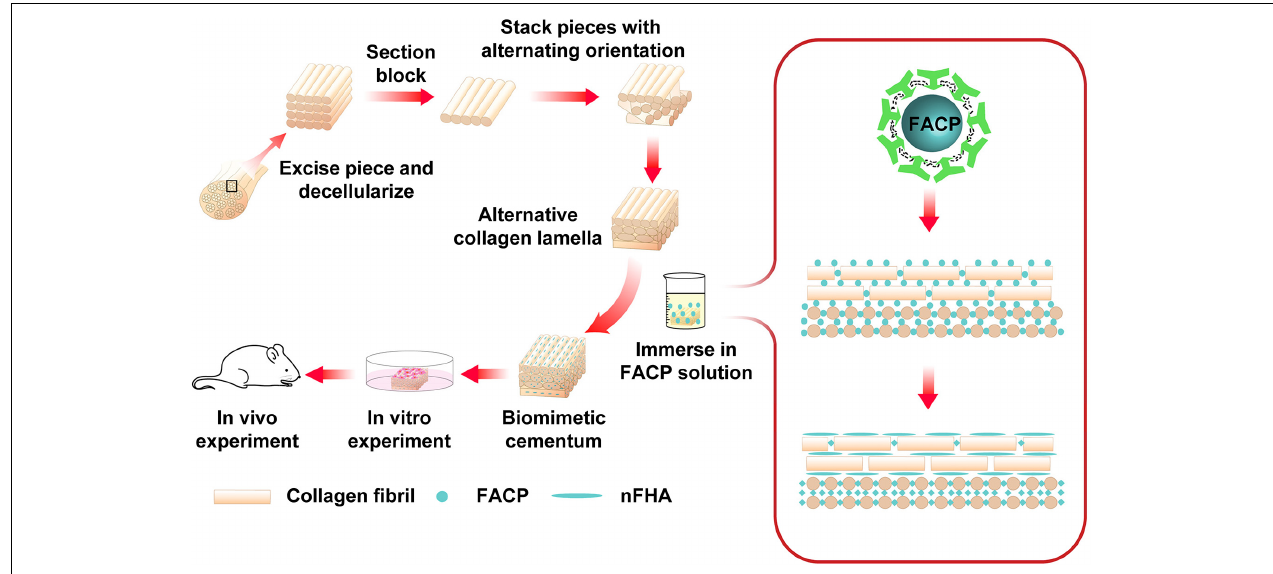
FIGURE 1 | Schematic illustration of the construction of biomimetic cementum via a combination of bioskiving and fluorine-containing biomineralization.